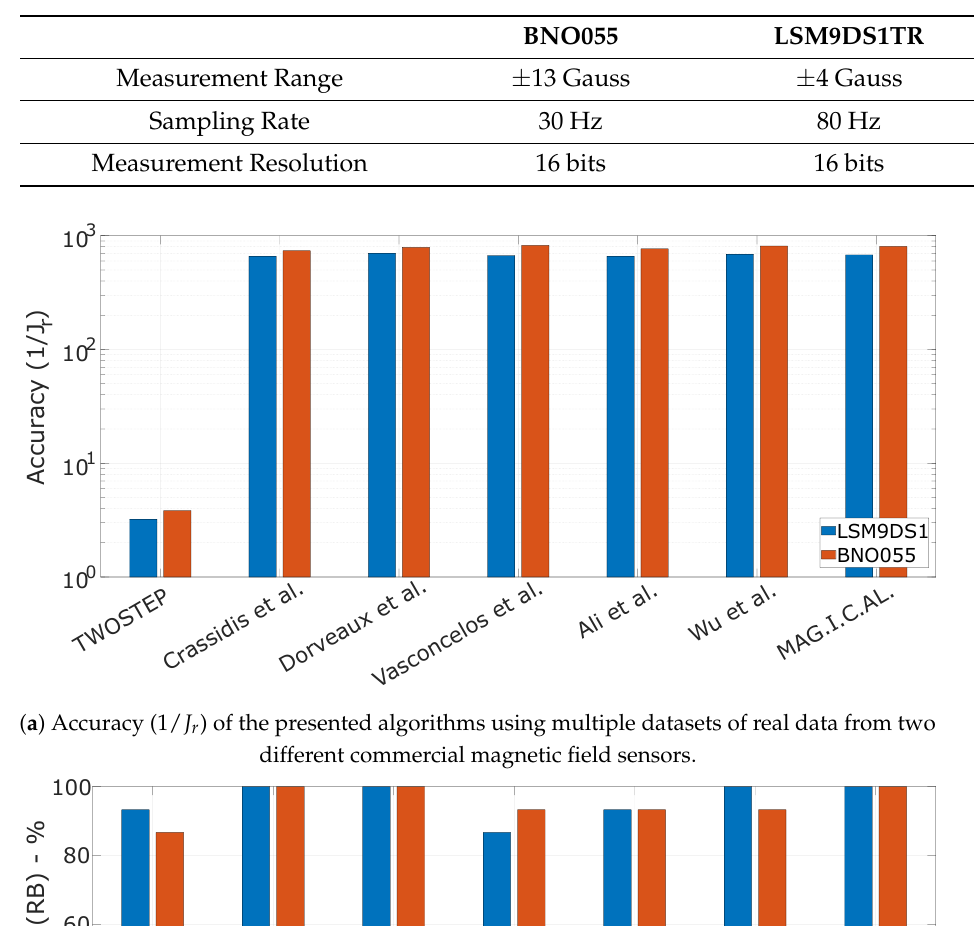
Table 3. Operation parameters of the two magnetic field sensors.